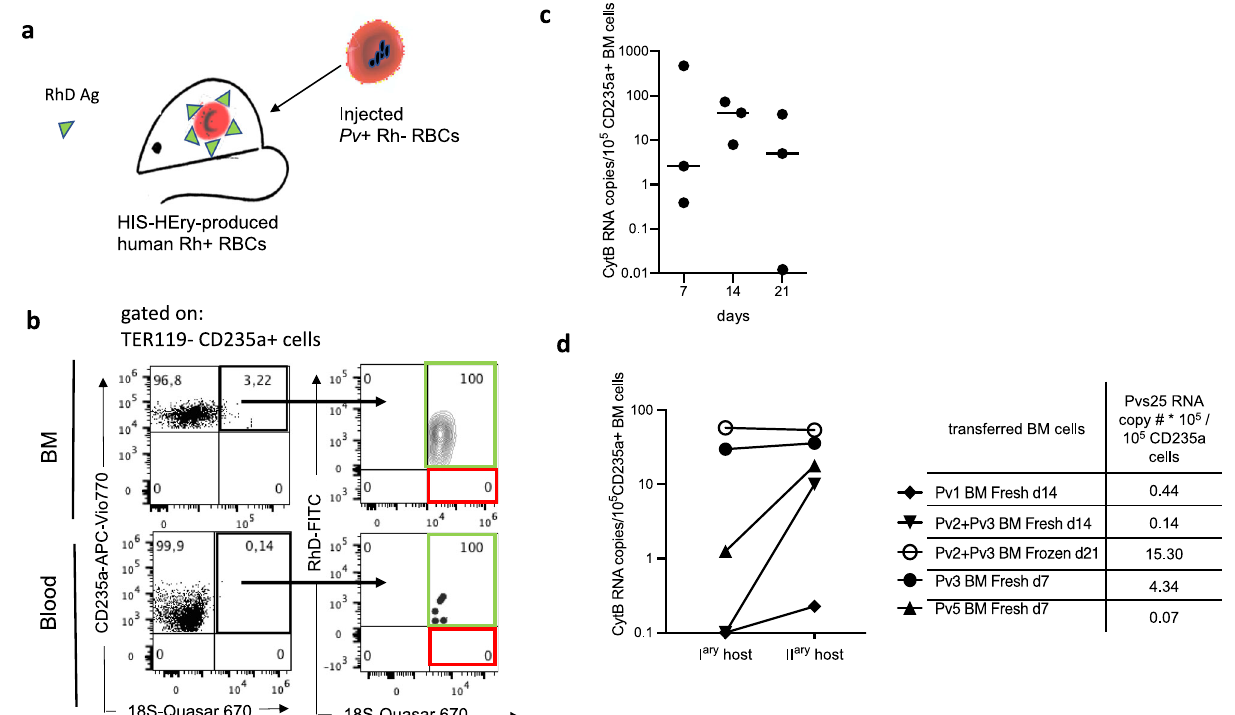
Fig. 2 HIS-HEry chimeras support P. vivax infections. a HIS-HEry mice that produced human RhD + RBCs ( green ) were infected with P. vivax -infected RhD − RBCs from a patient ( red ). b Representative plots show the FlowFISH analyses of P. vivax -speci fi c 18S rRNA expression in day-7-infected HIS-HEry mice. Cells were gated as alive TER119 − CD235a + . ( Left ) Upper and lower plots show the proportion of human CD235a + 18S + infected BM and PB cells (highlighted in black), respectively. ( Right ) The proportions of human endogenous RhD + RBCs among the CD235a + 18S + RBCs are highlighted in green; the proportions of injected RhD − RBCsamong theCD235a + RBCsare highlighted inred. c HIS-HErychimeras n = 8 micereconstitutedwithCD34 + cellsfromthe sameCBdonor were infected with a mixture of P. vivax isolates (Pv2 + Pv3, see table in panel d ). Plot shows the numbers of P. vivax CytB RNA copies per 10 5 CD235a + BM cells detected with qRT-PCR on days 7, 14, and 21 post-infection. Each dot represents one individual mouse. Mean CytB RNA copy numbers are: day 7 = 2.59, day 14 = 41.31, and day 21 = 5.01. Source dataareprovidedasa Source Data fi le. This experiment isrepresentative of3 independent experiments. d Human BM RBCs from individual, infected HIS-HEry mice were adoptively transferred into secondary naive HIS-HEry recipient mice. Plot shows the numbers of P. vivax CytB RNA copy numbers per 10 5 human BM RBCs cells, compared between donor (I ary host) and secondary (II ary host) hosts, at 7 days after transfer. The characteristics of the BM donor cells (i.e., the Pv isolate, the day post-infection, the fresh or frozen state, and the Pvs25 RNA copy numbers per 10 5 human RBCs) are indicated in the table; n = 5 donor and 5 secondary host mice. Source data are provided as a Source Data fi